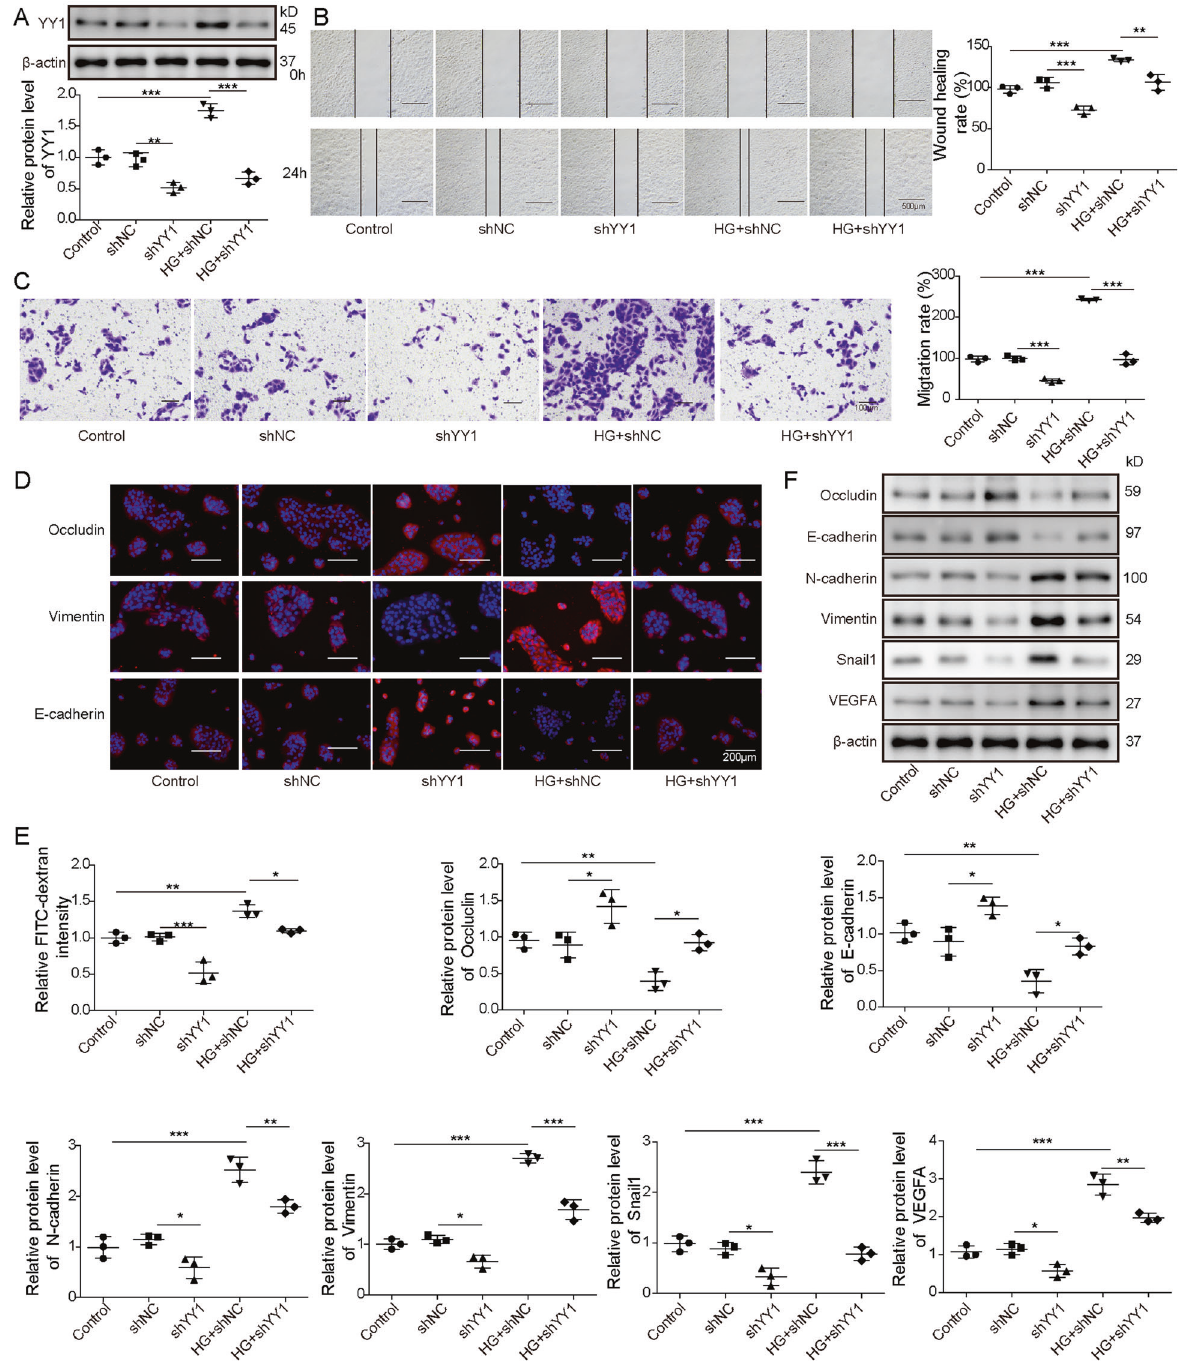
Fig. 3 The inhibitive effect of YY1 knockdown on expression of VEGFA and Snail1, and HG-induced EMT and cell permeability of ARPE-19 cells. ARPE-19 cells were transfected with shNC or shYY1 before treatment of HG. A YY1 level was detected by western blotting in the treated cells. B , C The migratory ability was examined via wound-healing analysis and transwell assay in the treated cells. D Occludin, E-cadherin, and Vimentin abundances were detected via immuno fl uorescence in the treated cells. E Cell permeability was analyzed by FITC-dextran assay in the treated cells. F VEGFA, Snail1, Occludin, E-cadherin, N-cadherin, and Vimentin abundances were measured by western blotting in the treated cells. For each analysis, three technical replicates were performed and three biological independently performed replicates are included, * p < 0.05, ** p < 0.01, *** p <